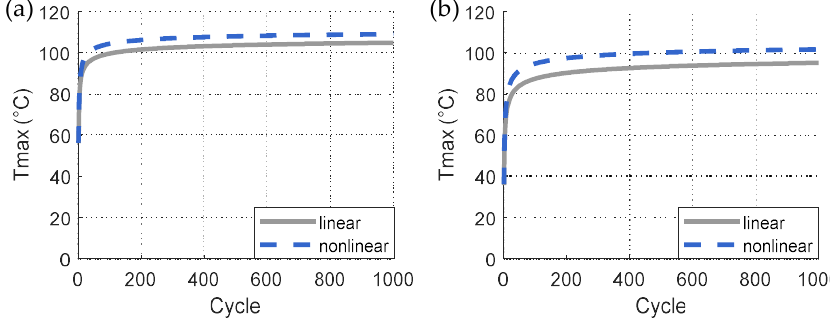
Figure 17. Comparison of maximum temperature with each cycle in the concrete section for the isolated pile between the linear and nonlinear thermal models at ( a ) the midpoint and ( b ) the outer surface of the pile section.